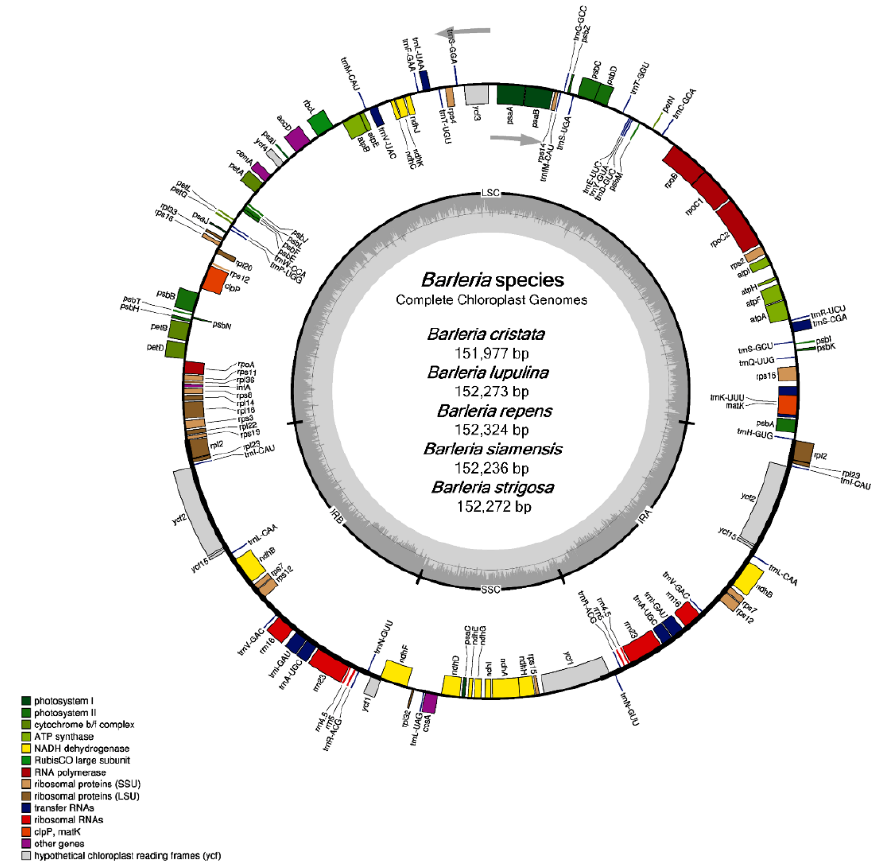
Figure 1. Gene map of the five species of Barleria chloroplast genomes. The inside circle genes are transcribed clockwise, whereas the outside circle genes are transcribed counter-clockwise; the color codes are described for the different function groups of the genes; the thick lines indicate the boundary of the inverted repeats (IRA and IRB), demarcated between the large single-copy (LSC) and small single-copy (SSC) regions; the dark gray area in the inner circle represents the genomic GC content, whereas the light gray indicates the AT content,